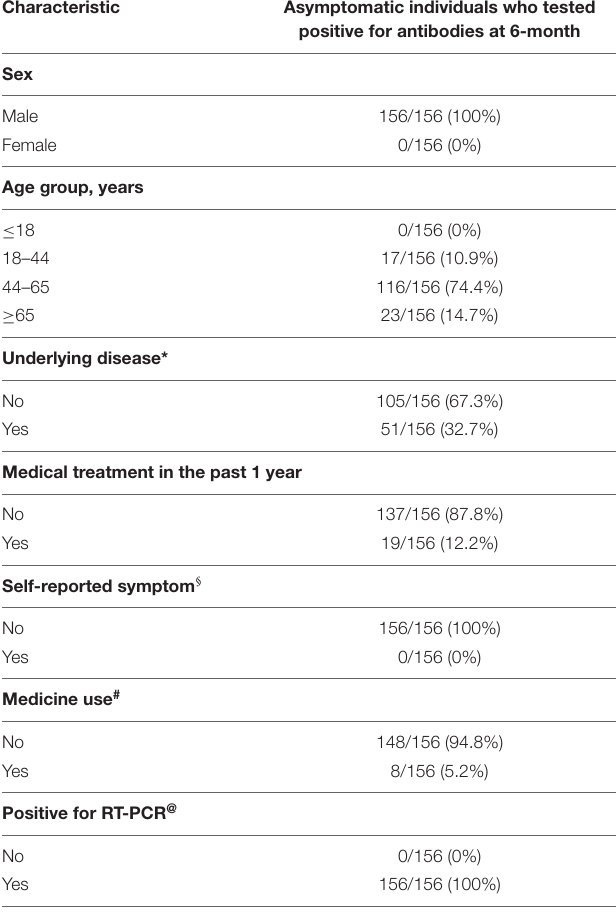
TABLE 1 | Characteristics of enrolled patients asymptomatic infected with SARS-CoV-2.